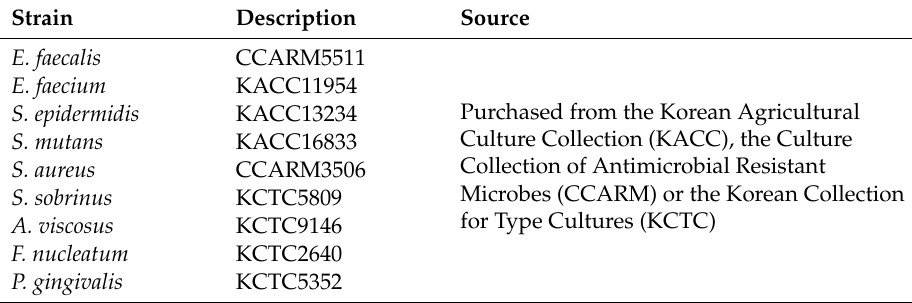
Table 1. Strains used in this